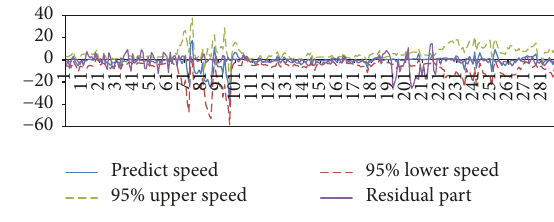
Figure 7: The residual prediction results.